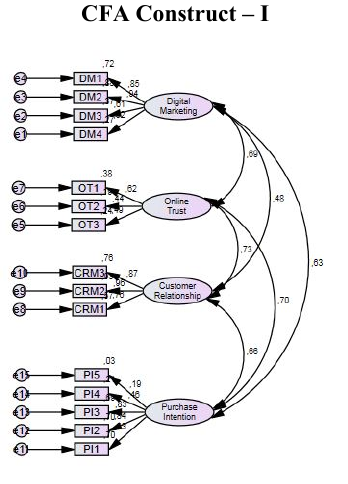
Fig. 2. Results of confirmatory factor analysis